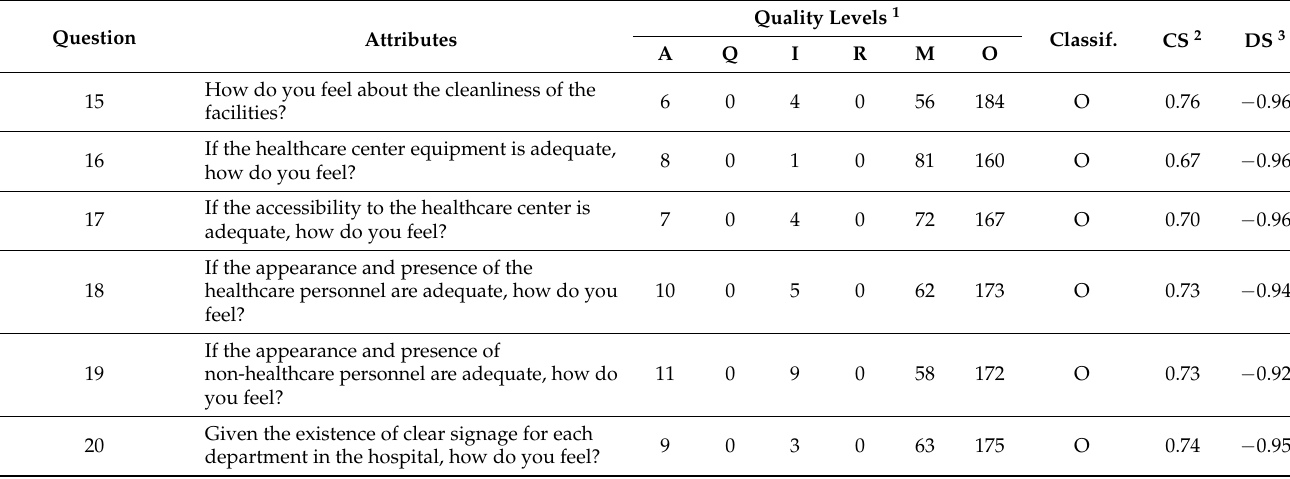
Table 6. Results corresponding to the facilities, equipment, and tangibles dimension.